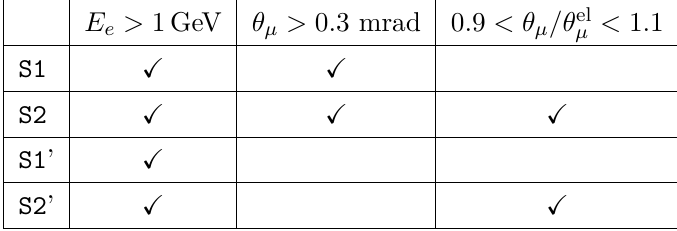
Table 1 . Kinematical scenarios analysed in the McMule